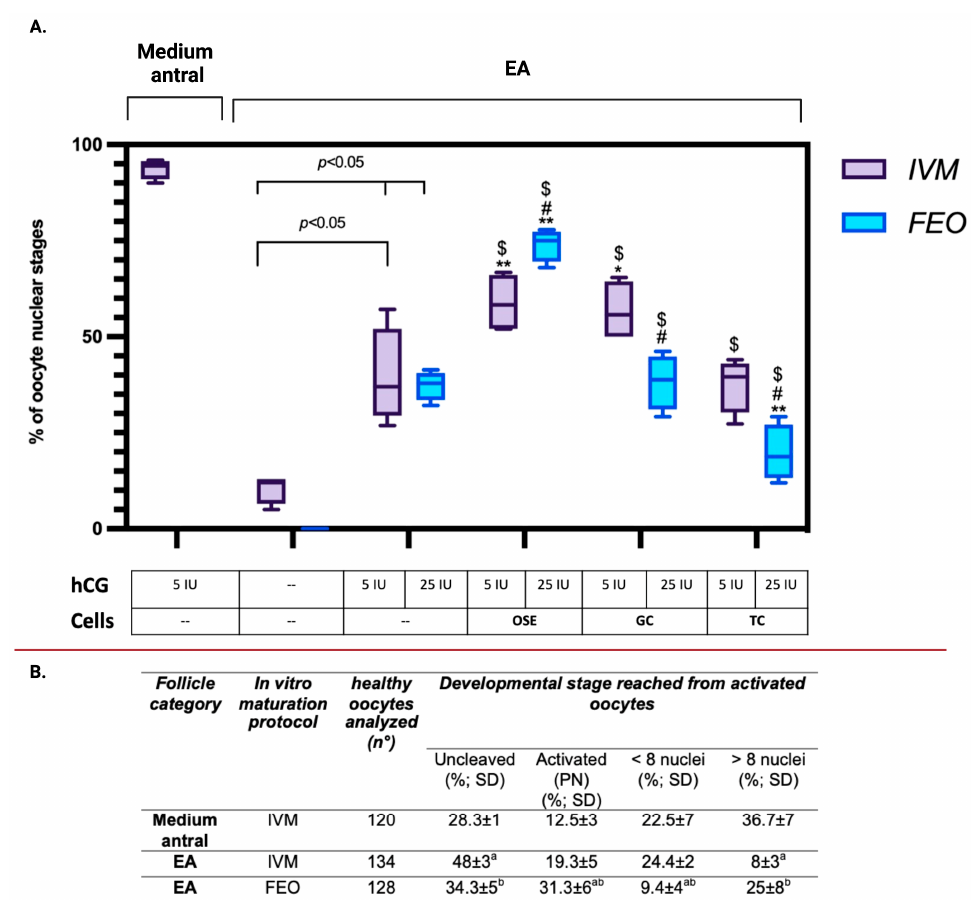
Figure 9. ( A ) Comparison between somatic cells’ coculture effect on FEO and IVM protocol. Four independent biological replicates were performed for each tested experimental group (total number of oocytes analyzed: 136 and 134 respectively for IVM and FEO Ctr without CG, 148 and 138 for IVM and FEO Ctr without cells coculture, and 143 and 144 for IVM and FEO with OSE, 140 and 142 for IVM and FEO with GC, and 135 and 137 for IVM and FEO with TC). The significance of MII data collected in different cell-coculture experimental groups was analyzed within each protocol (IVM or FEO) vs. EA-derived oocytes as negative Ctr (5 IU/mL hCG or 25 IU/mL hCG without cells, respectively, for IVM and FEO) and indicated with (*) or (**) superscript for p < 0.05 or p < 0.01. The significance of MII data collected in different cell-coculture experimental groups was analyzed within each protocol (IVM or FEO) vs. medium antral-derived oocytes as positive Ctr (5 IU/mL hCG without cells for IVM) and indicated with ($) superscript for p < 0.05. The significance of MII data between the two protocols (IVM vs. FEO) in each cell-coculture experimental group (OSE or GC or TC) was analyzed and indicated with (#) superscript for p < 0.05. ( B ) The developmental stage reached from parthenogenetic oocytes activation after 72 h of incubation. The parthenogenetic activation was performed on MII oocytes (extruded PB) obtained from IVM, and FEO optimized EA protocols (with OSE and hCG) and compared with that of IVM oocytes derived from medium antral follicles (positive Ctr). Three independent biological replicates were performed for each tested experimental group (total number of oocytes analyzed: 120, 134, and 128, respectively, derived from medium antral, IVM, and FEO protocols). The data were statistically analyzed, and the significant values for p < 0.05 were indicated with a vs. medium antral; b vs. EA IVM. In order to assess the exclusive quality of oocyte cytoplasm, the activation was induced by using a chemical stimulus (ethanol) and not through fertilization. The Moreover, the stimulatory influence of somatic cell coculture on maturation resulted in being either cell- or protocol-dependent. Only ovarian-derived cells were able to exert an inductive maturation effect in both IVM and FEO. However, amongst the reproductive-derived cells, the GCs were able